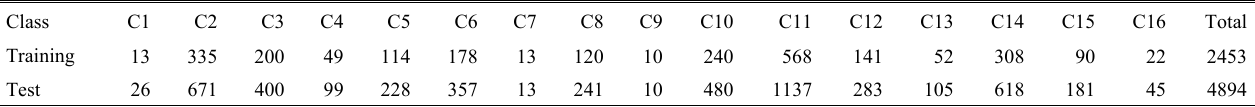
Table 5. Numbers of training and test samples from the AVIRIS indian pines data set. Test samples were the same as in Table